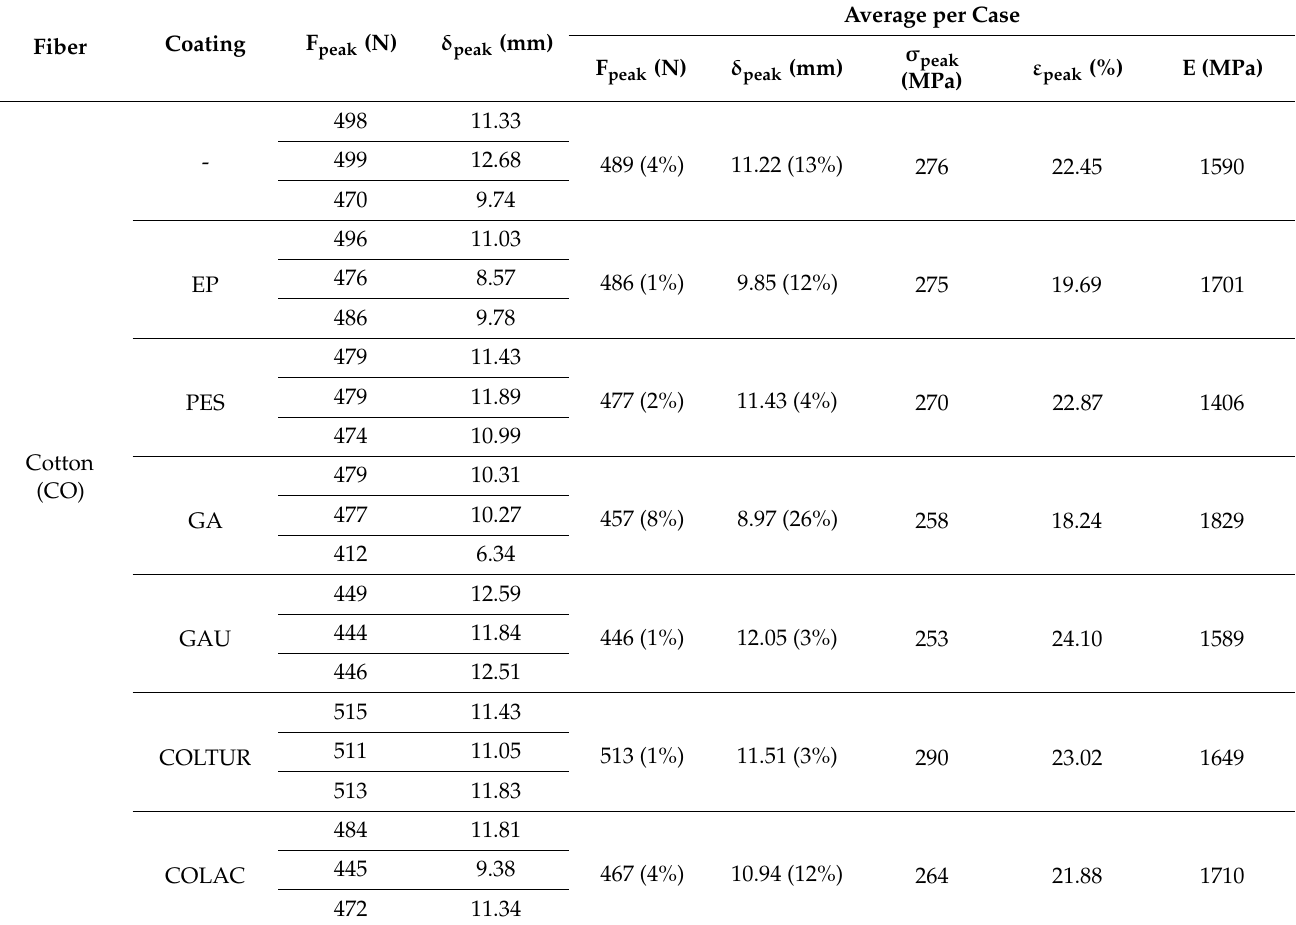
Figure 5. Load–extensometer curves for hemp yarns. Figure 5. Load – extensometer curves for hemp yarns. Table 5. Cotton yarns’ tensile test